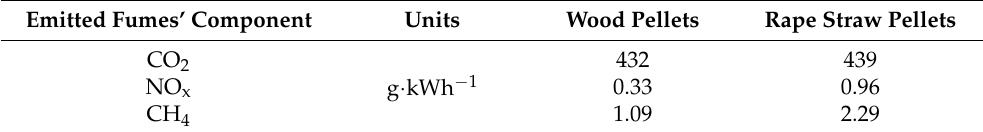
Table 5. Average emissions of GHG components (g · kWh − 1